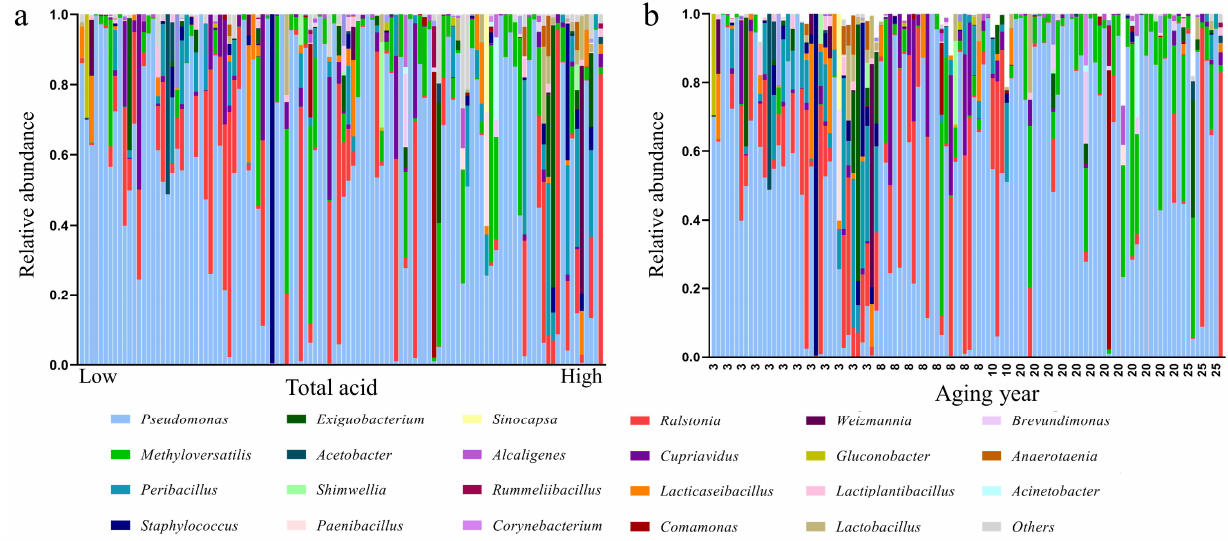
Figure 2. Distribution of genus of aged huangjiu samples. ( a ) Rank according to total acid. ( b ) Rank according to aging year.